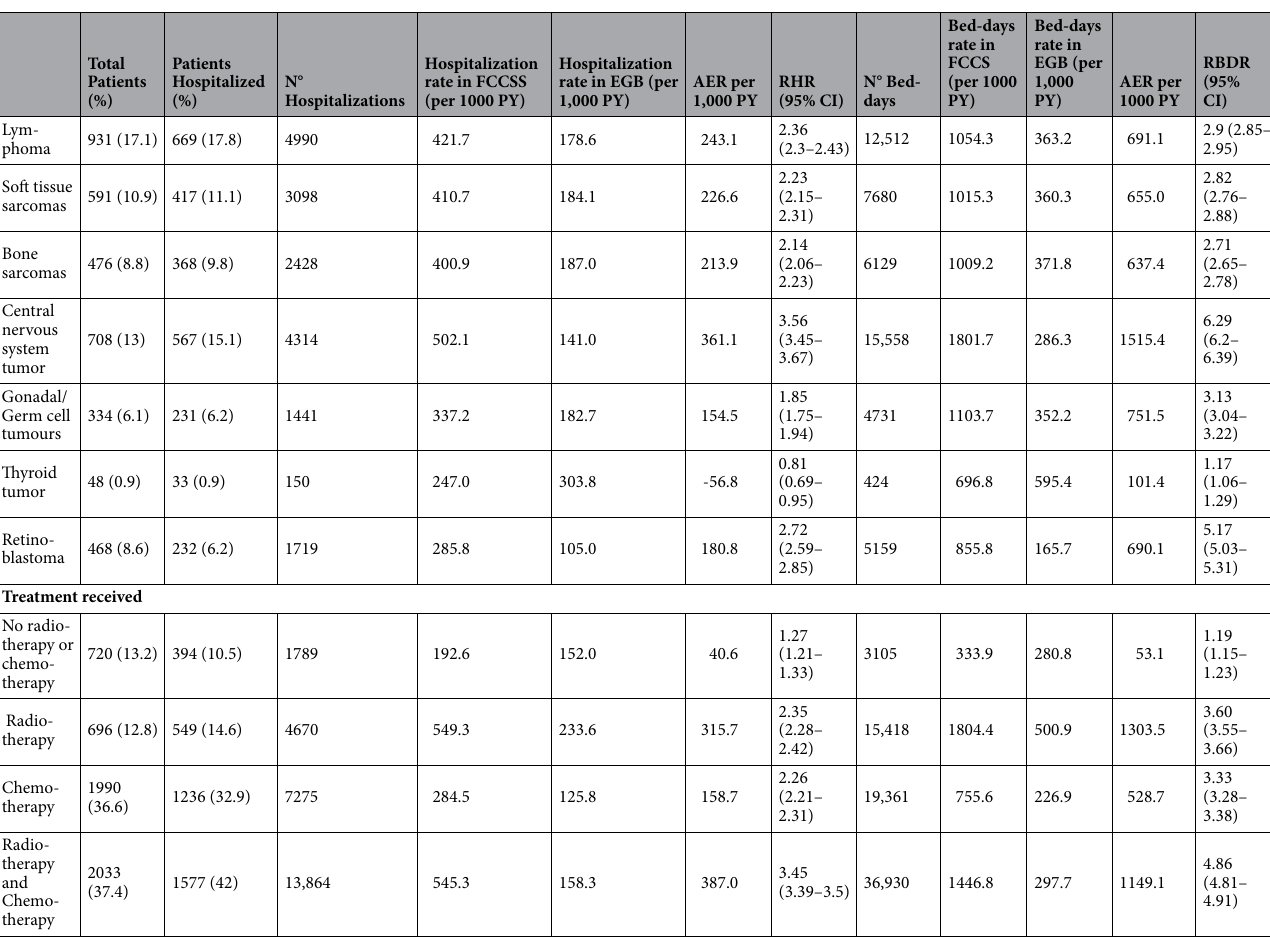
Table 1. Survivor characteristics and hospitalisation and bed-day rates. FCCSS, French Childhood Cancer Survivor Study; EGB, general sample of beneficiaries; AER, absolute access risk; PY, person-year; RHR, relative hospitalization ratio; RBDR, relative bed-days